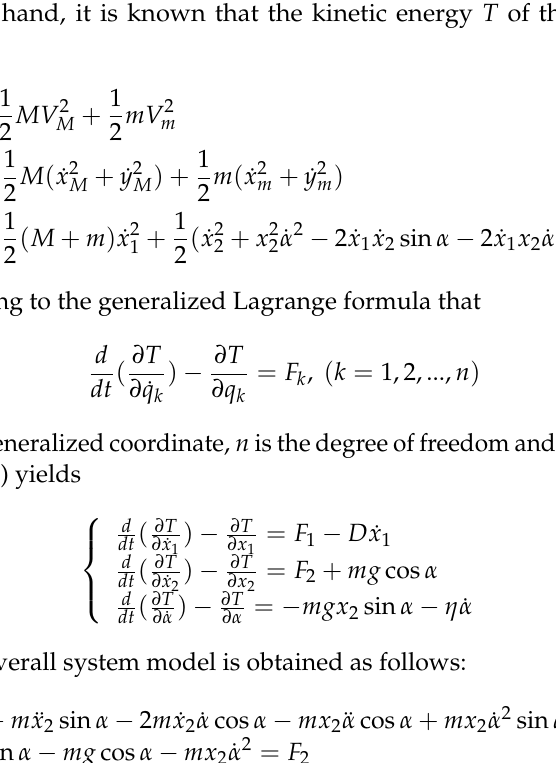
Figure 2. Physical model in a generalized